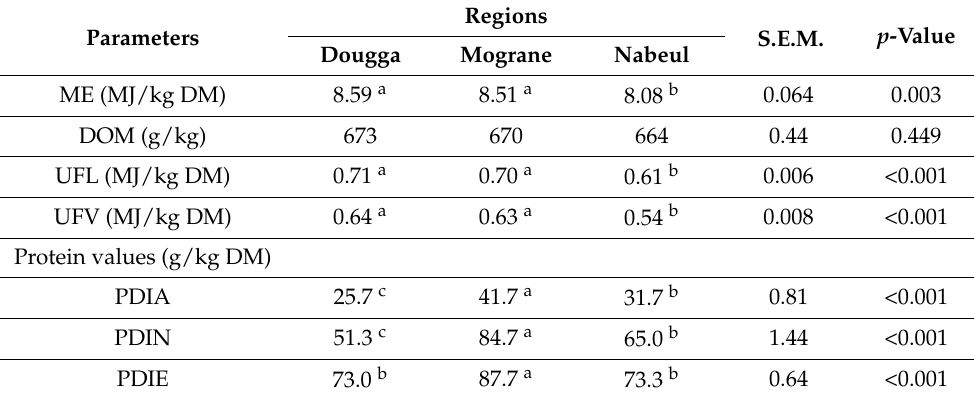
Table 4. Metabolizable energy (MJ/kg DM), digested organic matter (g/kg DM), energetic value (kg DM), and protein value (g/kg DM) of A. iva leaves cultivated from three different regions in